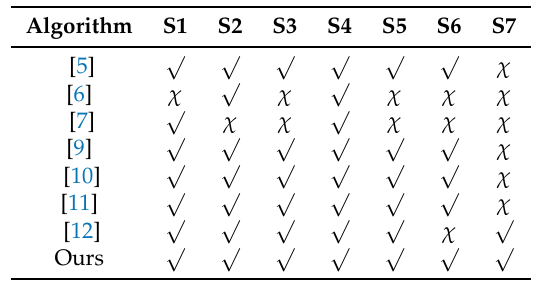
Table 7. Security comparison of various